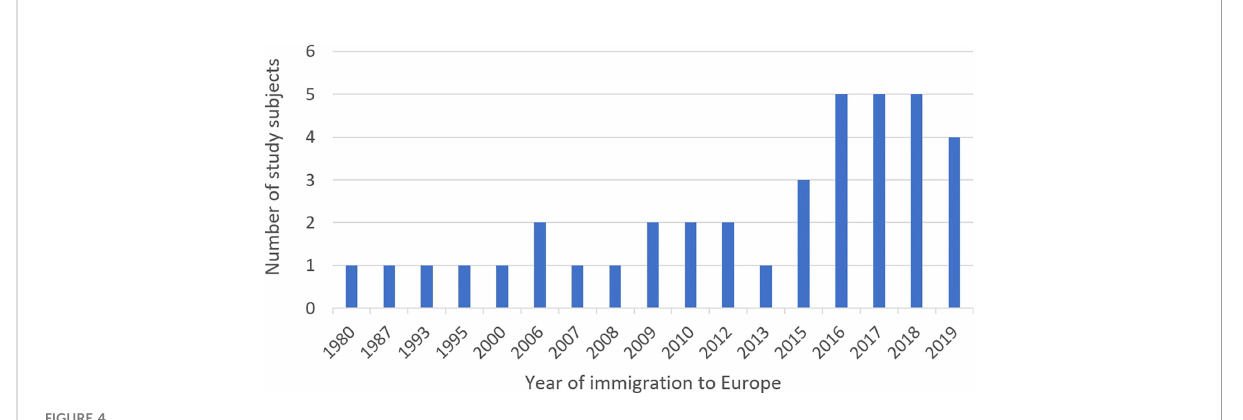
FIGURE 4 Year of immigration to Europe for all prospectively enrolled study